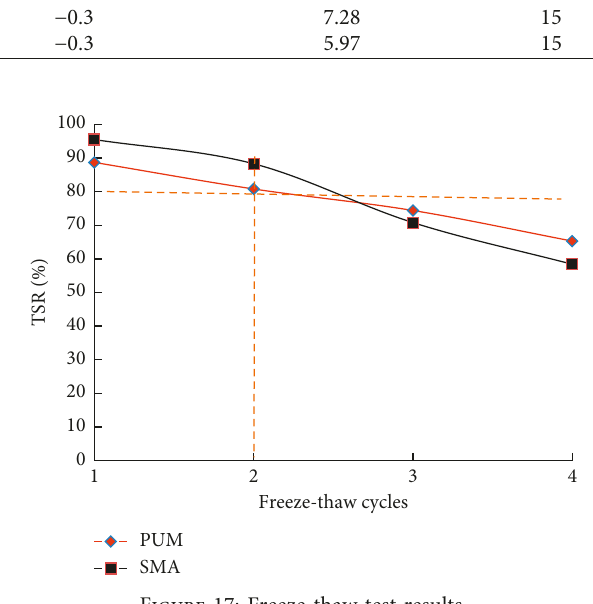
Figure 17: Freeze-thaw test